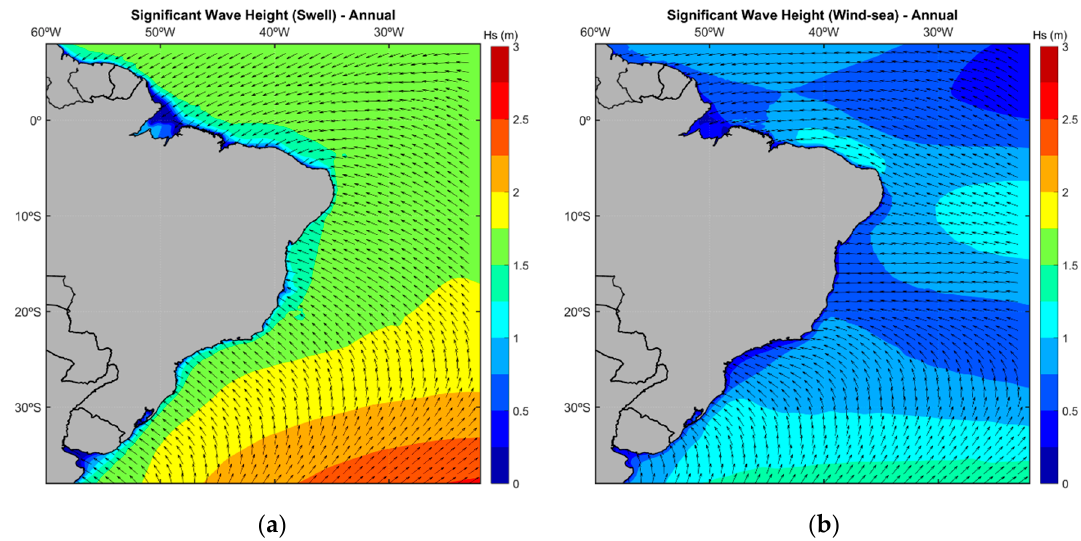
𝑠𝑠 (m) and 𝜃 (cid:3040)(cid:3046) (°), for Brazil. ( b ) Annual mean 𝐻